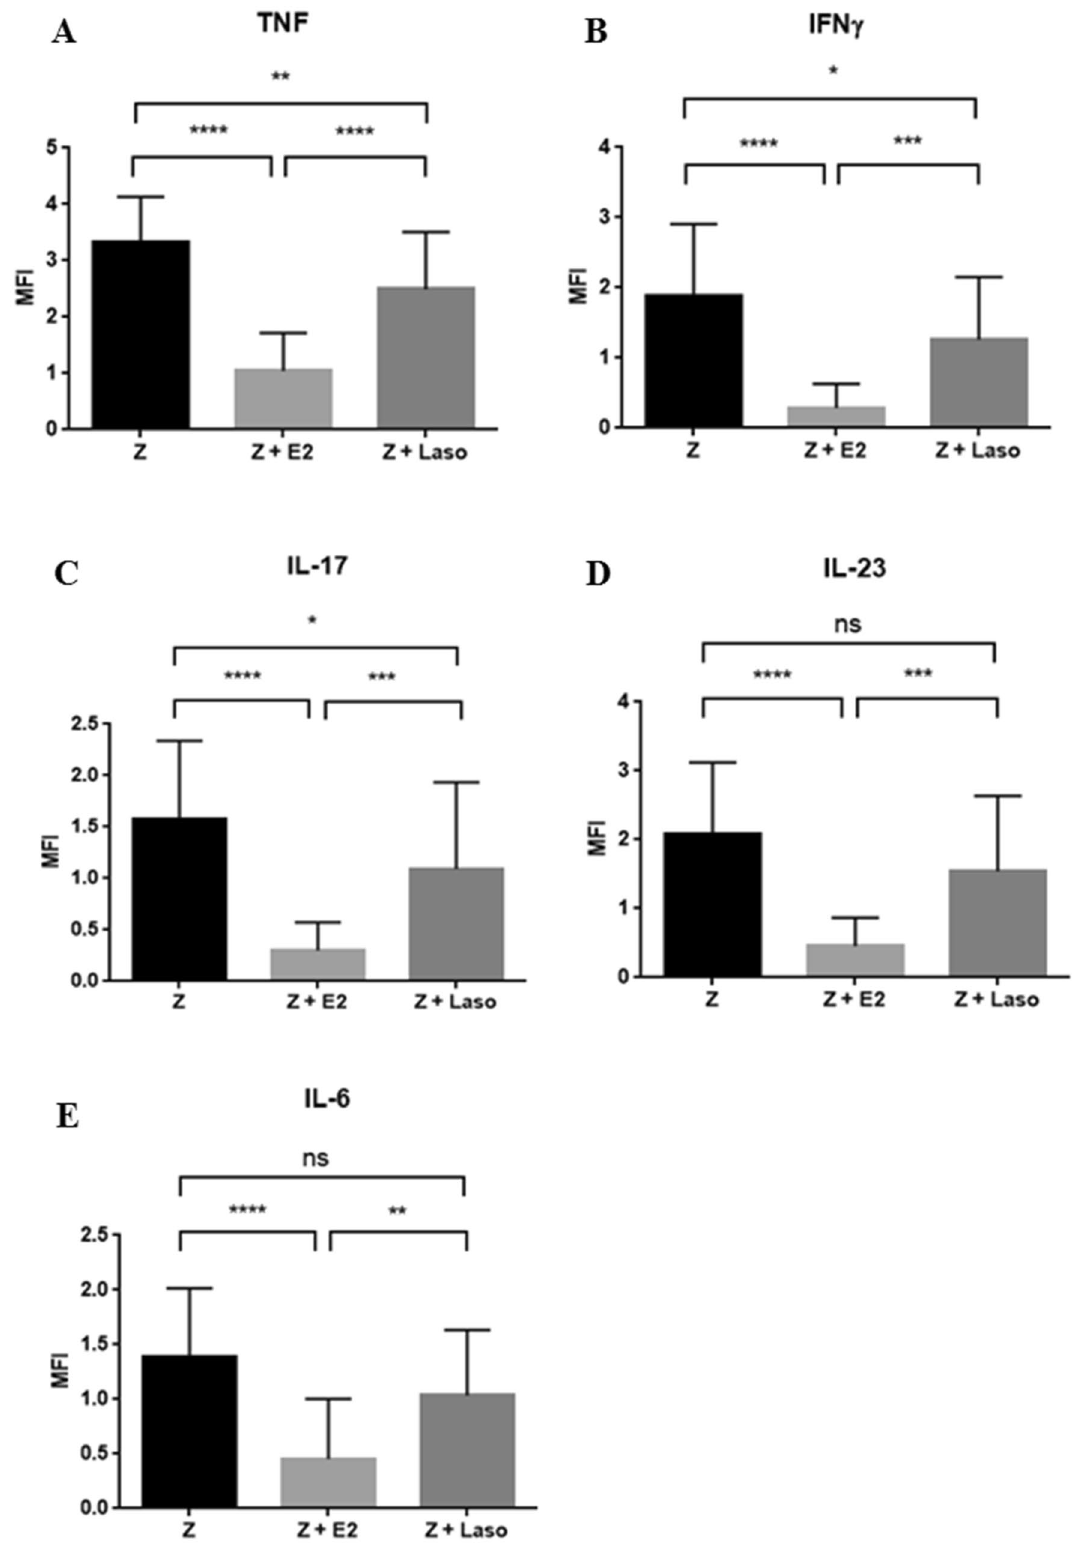
Figure 3. Local mRNA expression in hindpaw, forepaw, and tail was analyzed. Gene expression was calculated by median fluorescence intensity (MFI). A-E TNF-α ( A ), interferon gamma (IFN-γ) ( B ), IL-17 ( C ), IL-23 ( D ), IL-6 ( E ). Values are mean ± standard error of the mean ( n = 16 mice per group). Analyses were performed using GraphPad Prism (version 5.0; GraphPad Software Inc., La Jolla, CA, USA, https:// graph pad- prism. softw are. infor mer. com/5. 0/). * p < 0.05, ** p < 0.01, *** p < 0.001, **** p < 0.0001. Z zymosan, E2 17β-estradiol, Laso